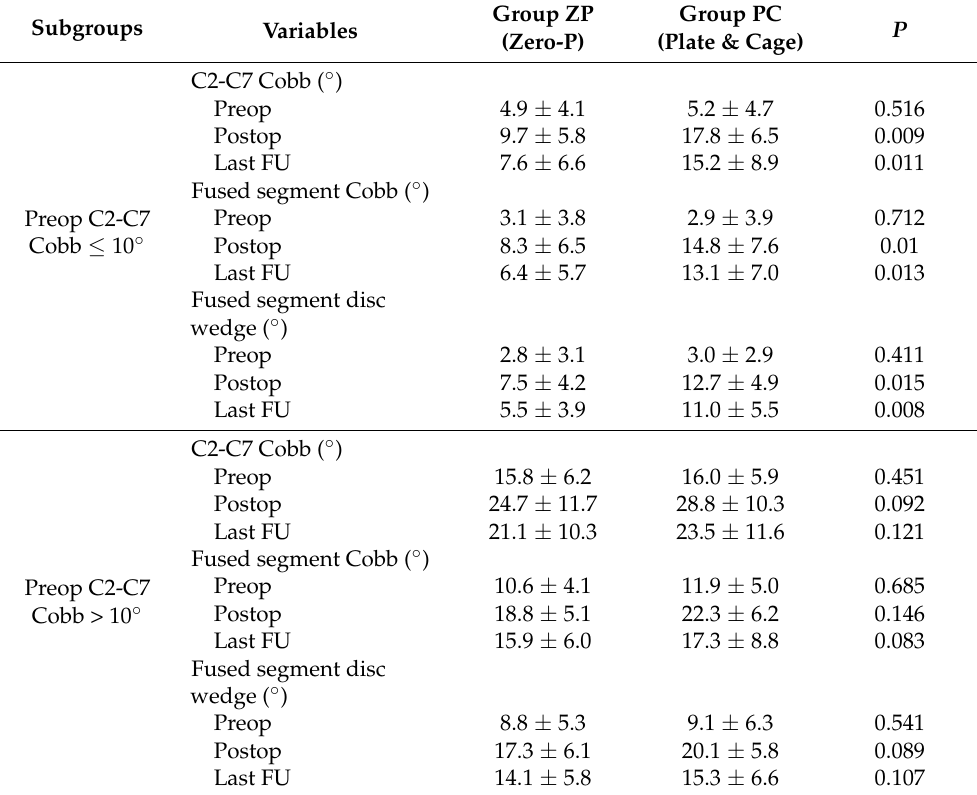
Table 5. Comparison of sagittal alignment by